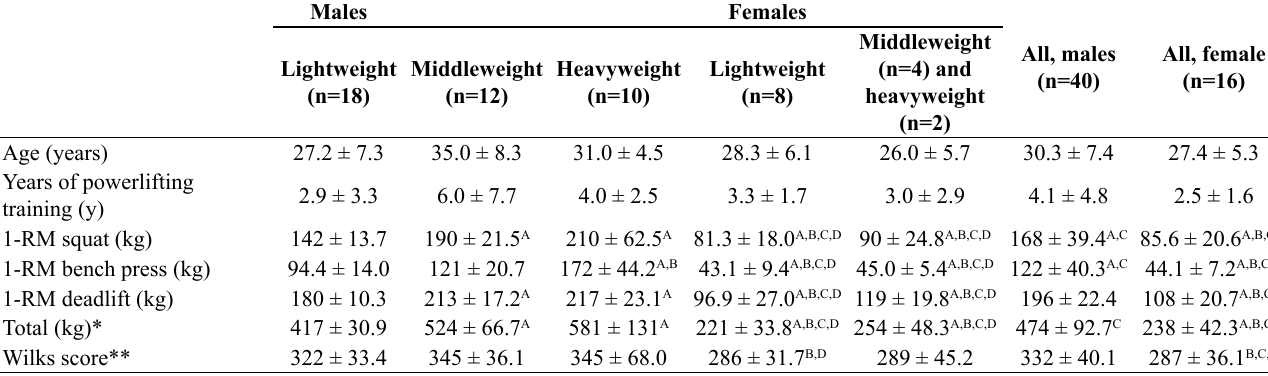
Table 1. Demographic characteristics of powerlifters (mean ± standard